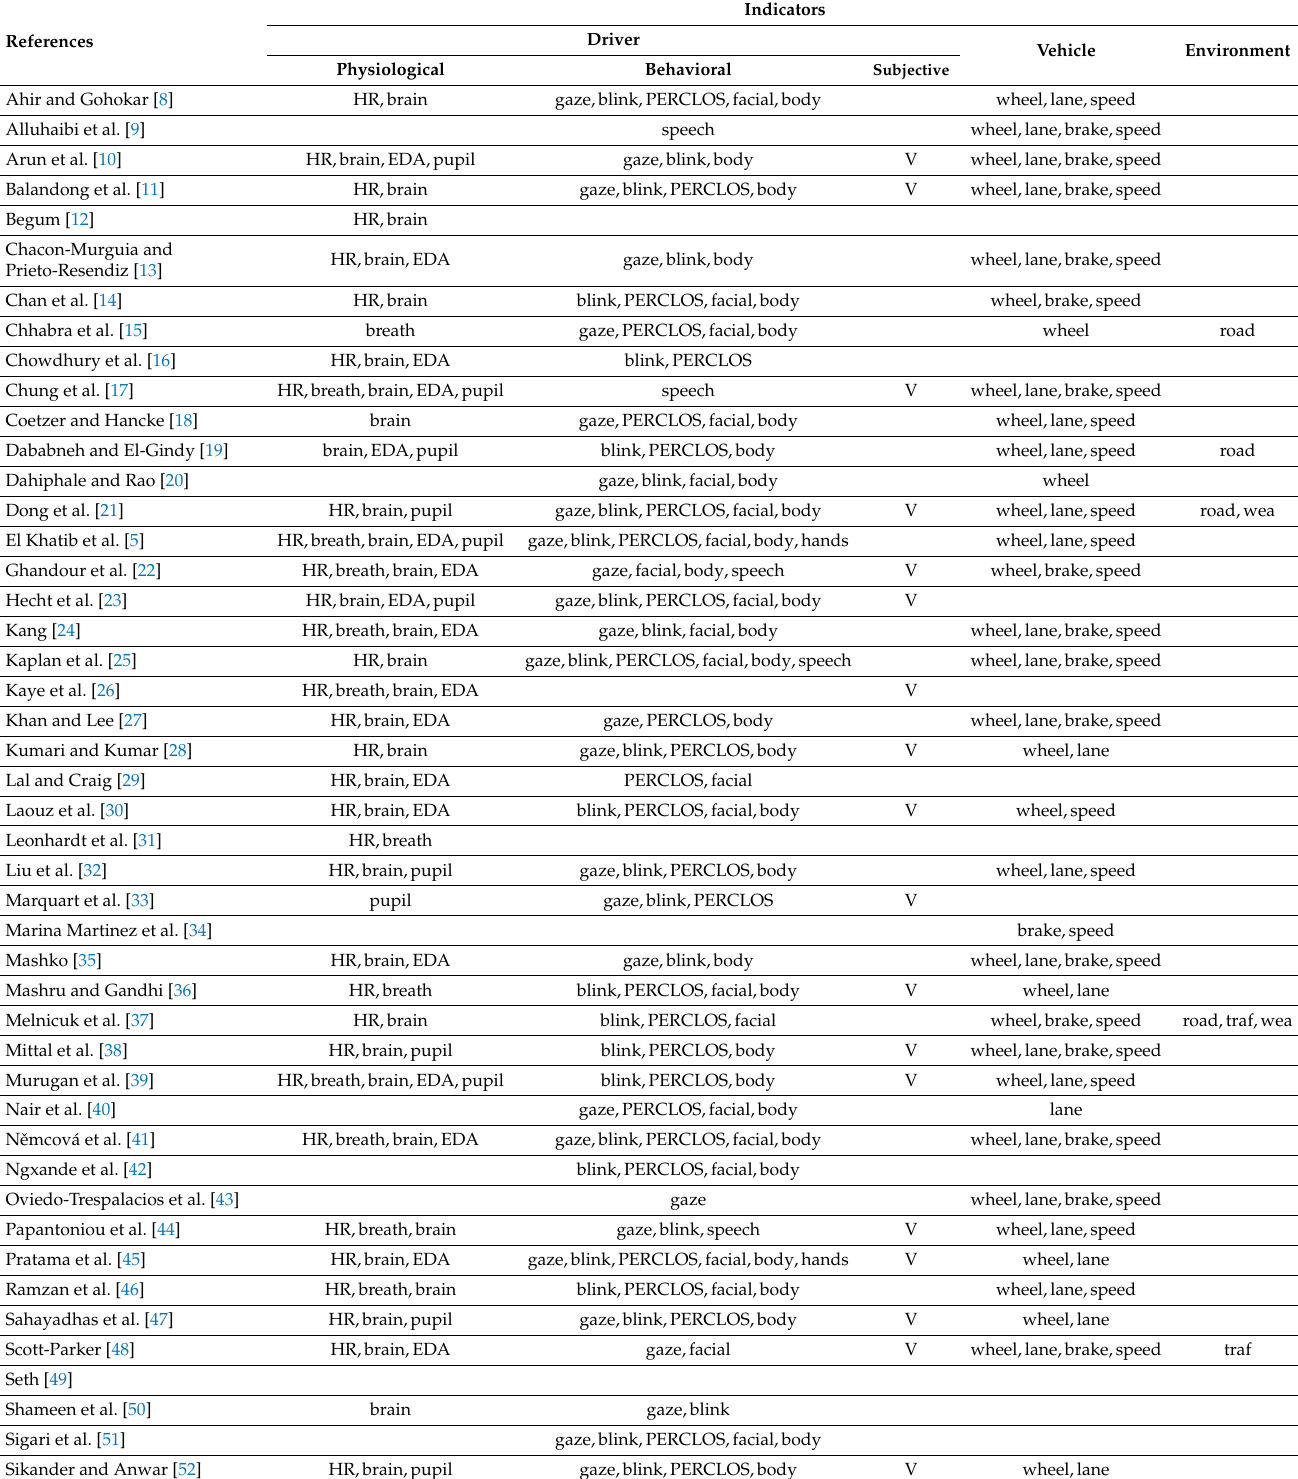
Table A2. This table gives the main column of Table 2 labelled “Indicators”. The three remaining main columns “States”, “Sensors”, and “Tests” are provided in Table A1. This partitioning of Table 2 allows for more comfortable visualization of its content when